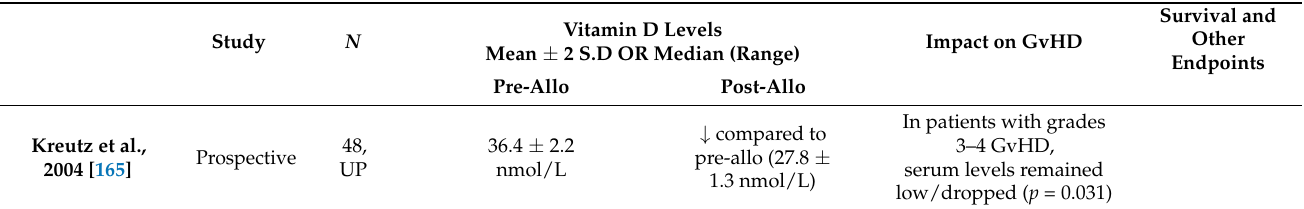
Table 2. Relationships between vitamin D levels and main outcomes after